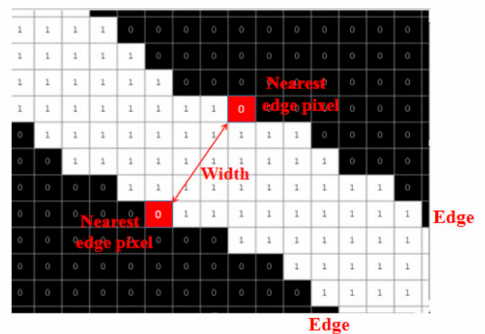
Figure 1. Illustration of the crack width.